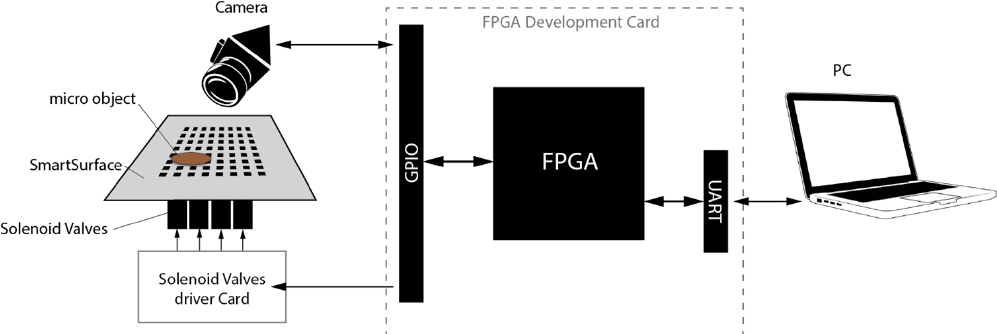
Figure 1. The system block diagram.